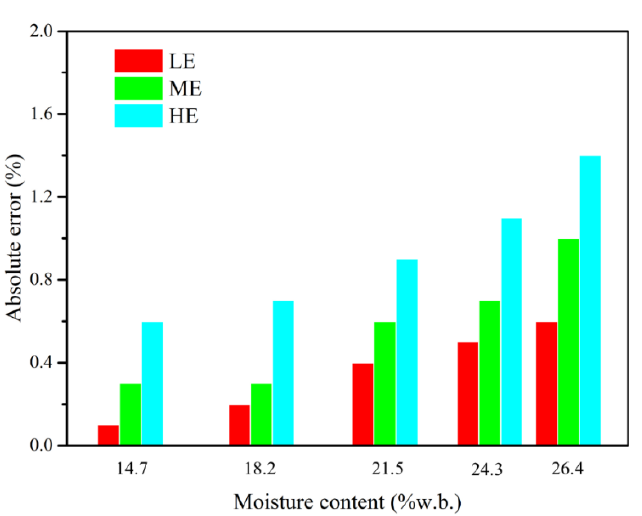
Figure 7. The moisture content deviation under different porosities. Note: LE, ME, and HE represent a low, medium, and high degree of extrusion, respectively.